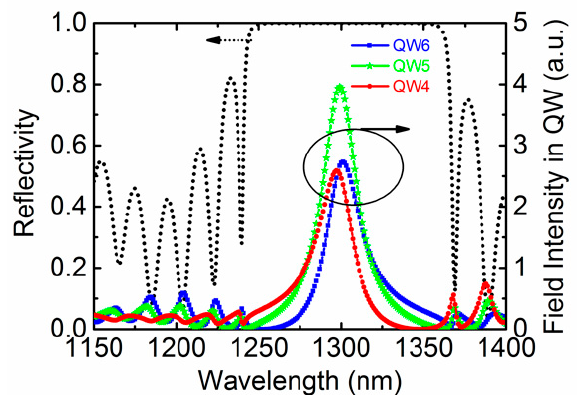
Figure 6. Simulated reflectivity as well as field intensity spectra in QD layers (QD#4, #5 and #6) for the modified structure without n-AlGaAs aperture layer.